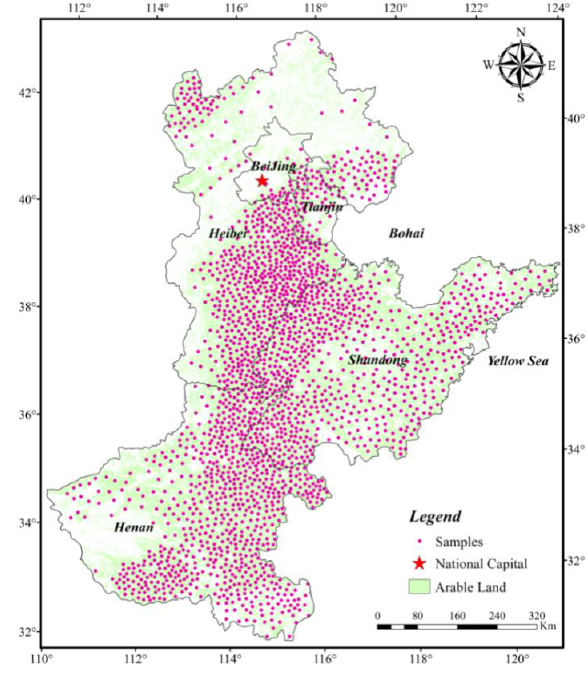
Figure 3. Distribution of dry land sample sites in the North China Plain.